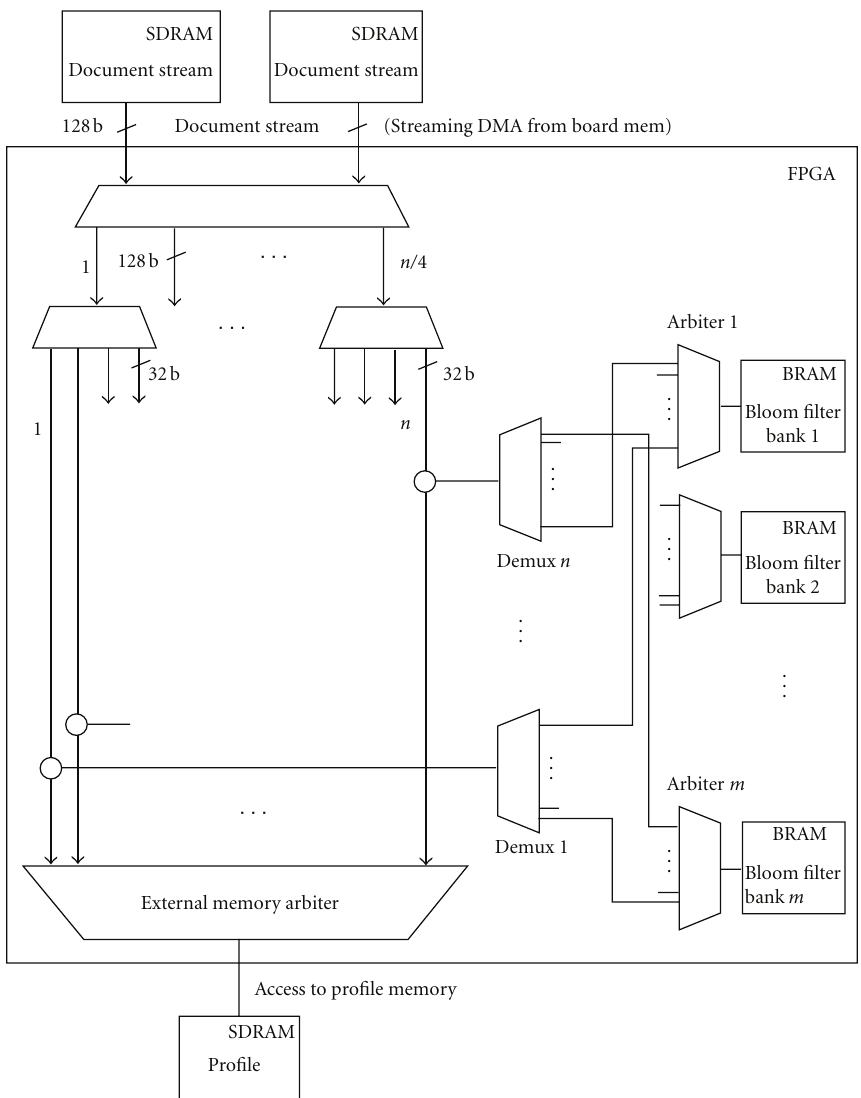
Figure 2: Parallelizing lookups using parallel streams and a multibank Bloom